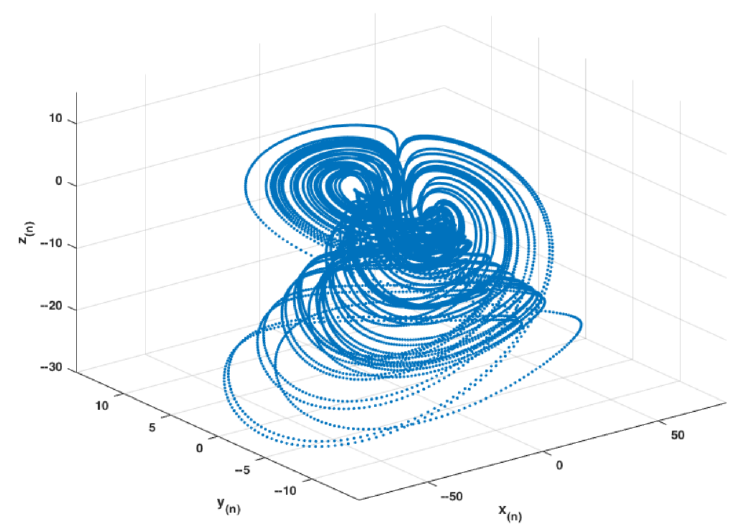
Figure 7. Hyperchaotic attractor of DV-system (14) projected on x ( n ) versus y ( n ) versus z ( n )